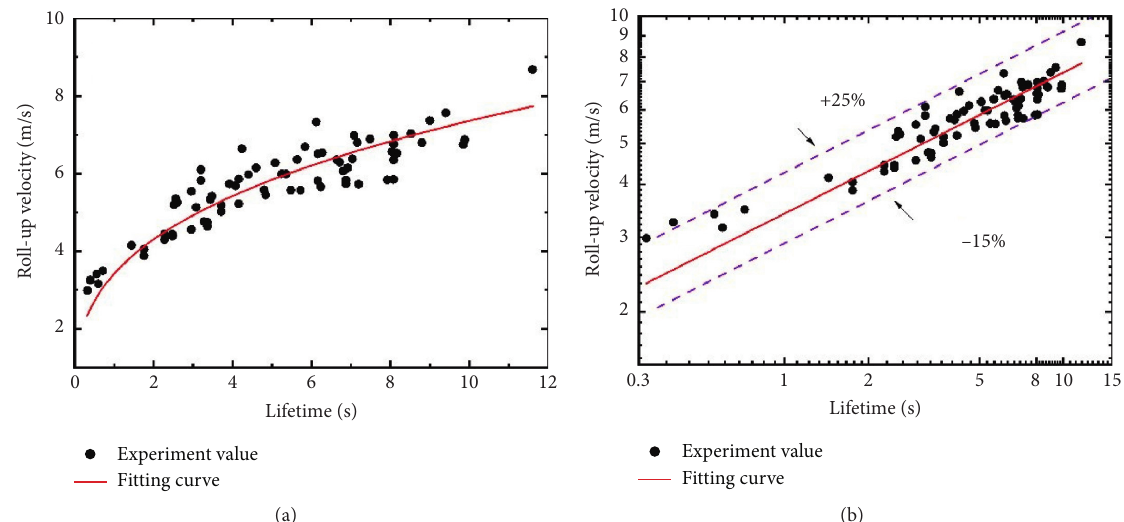
Figure 12: Correspondence of the film roll-up velocity and the bubble lifetime: (a) curve fitting and (b) error analysis.